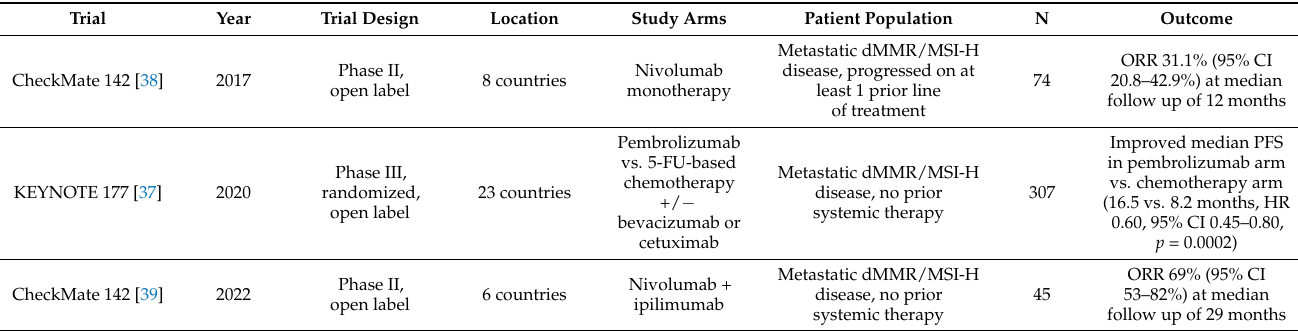
Table 2. Landmark trials of immunotherapy in colorectal